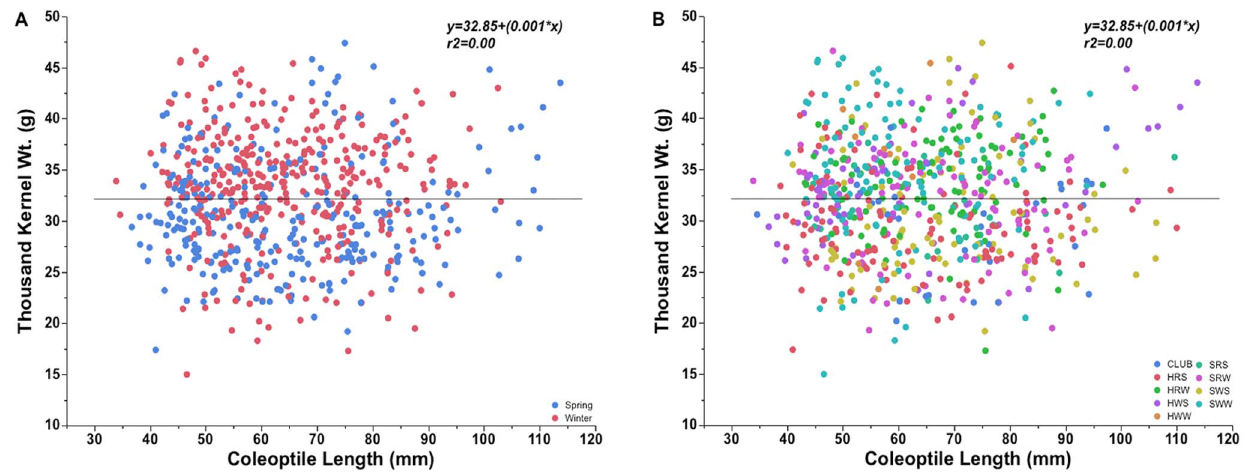
Figure 4. Thousand kernel weight of (A) spring and winter type wheat and (B) different market classes of world wheat collection entries plotted against coleoptile length.